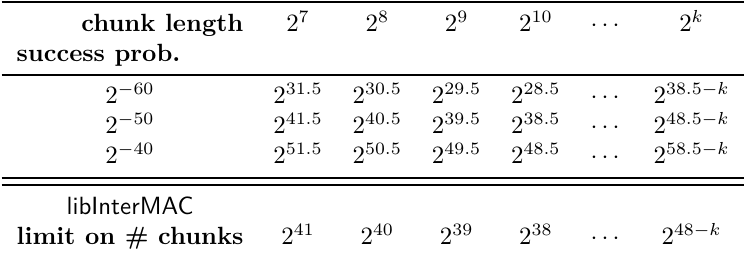
Table 2: Restrictions on the number of encrypted chunks as a function of the attack success probability and chunk length for AES - GCM . The right-most column shows the general formula for computing the restrictions on the number of encryption chunks for different attack success probabilities. The bottom row shows the limits on the number of encrypted chunks for different chunk lengths as implemented in libInterMAC